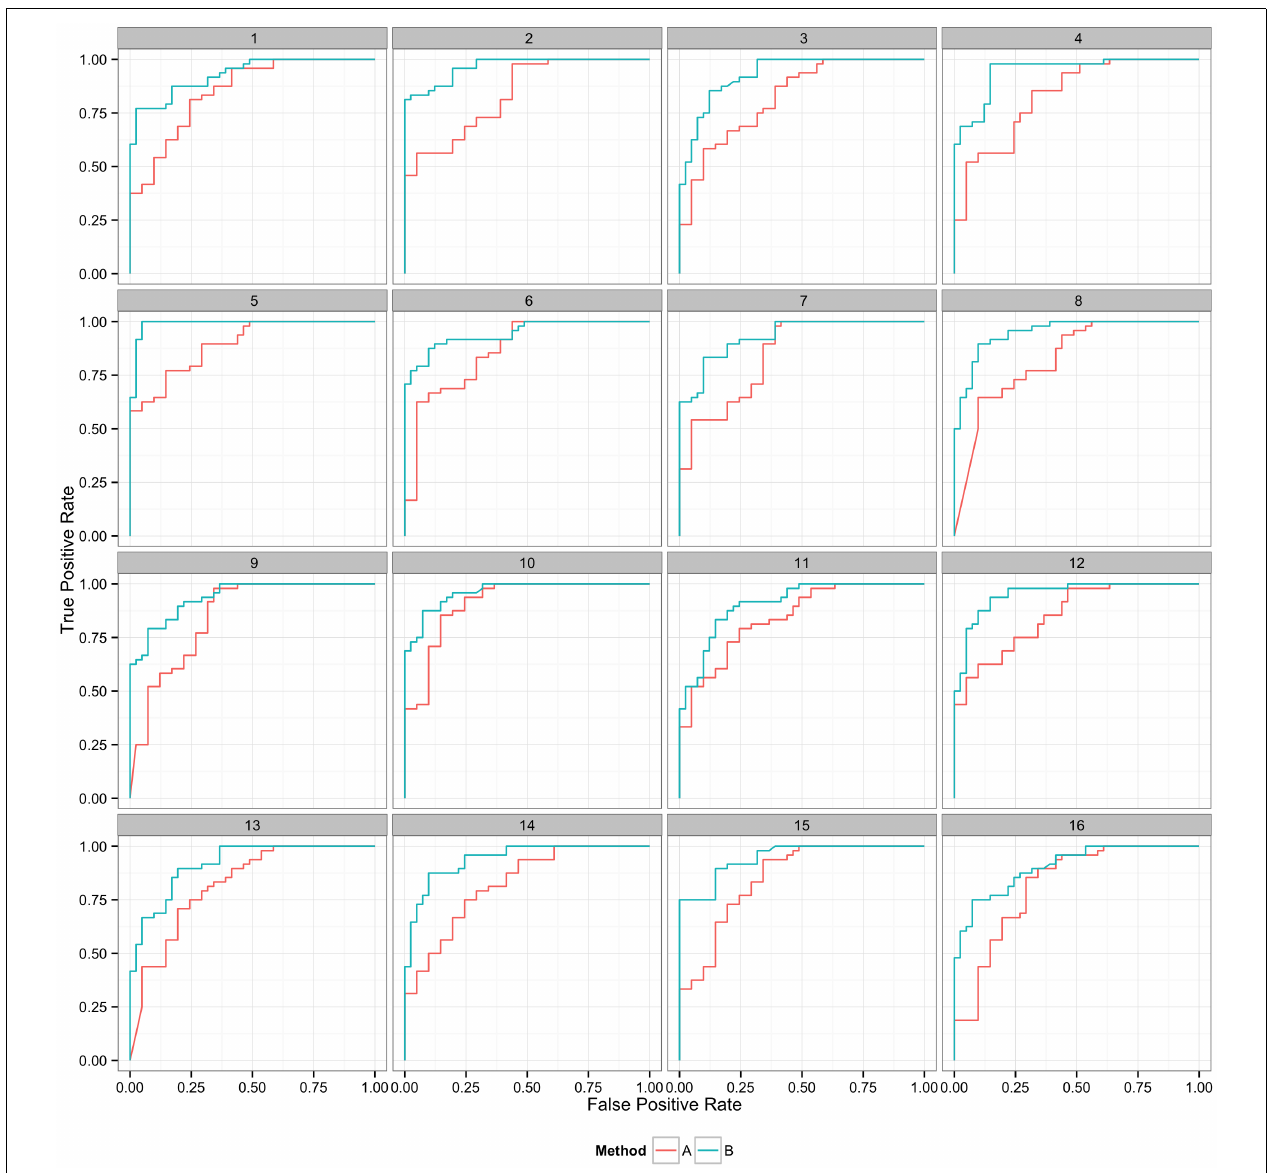
FIGURE 6 | Curves represent the relationship between the two performance metrics, in this case true positive and false positive rate. Replicate samples are plotted individually to indicate the robustness in the relative performance of the two methods.